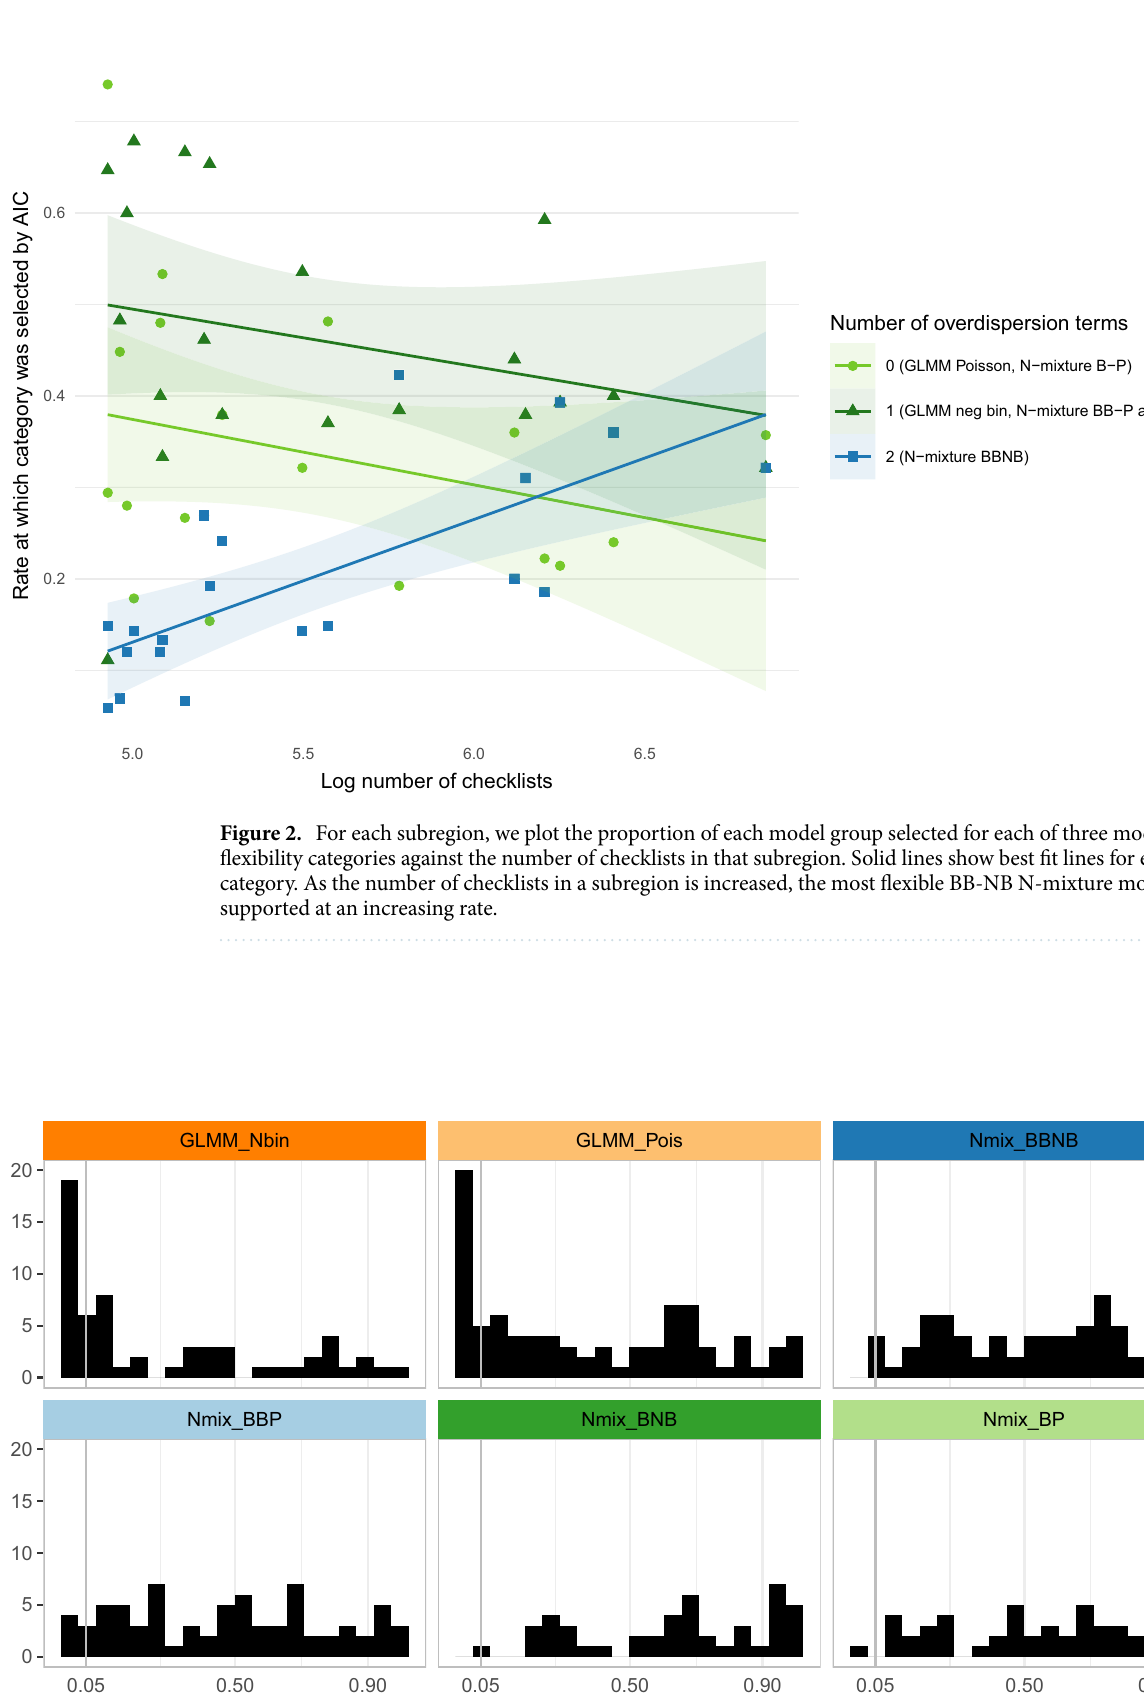
Figure 3. Goodness-of-fit p -values for N-mixture models selected by AIC had near-uniform distributions, while a subset of selected GLMMs showed goodness-of-fit